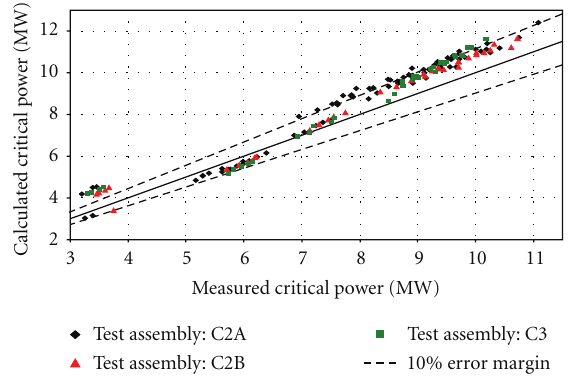
Figure 9: Comparison of calculated with measured critical power for di ff erent bundle arrangements.